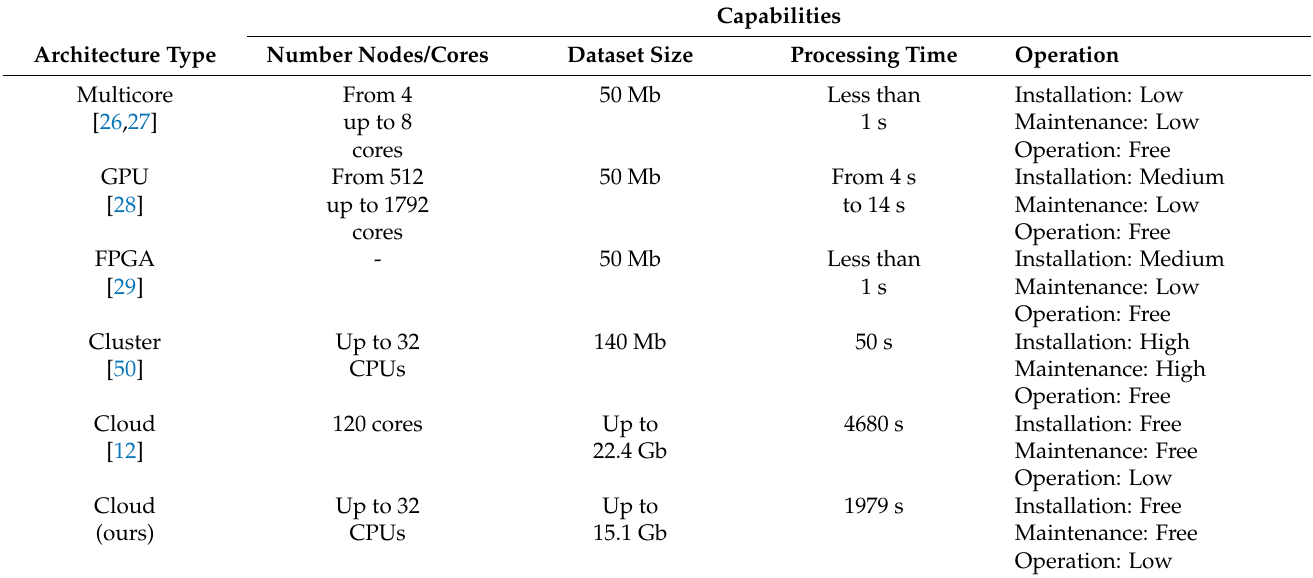
Table 1. Summaryofthecapabilitiesandoutcomesfoundintheliteratureforparallel/distributedmethods.